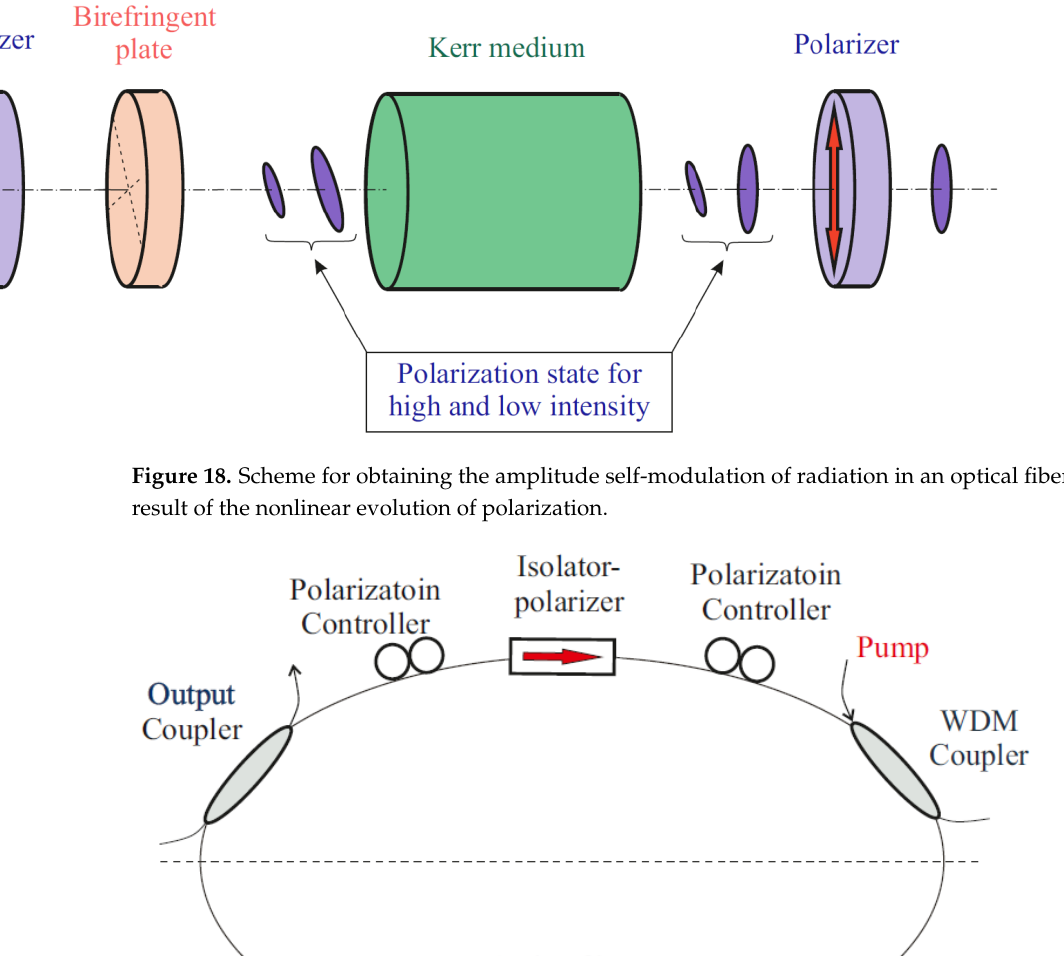
Figure 20. Nonlinear transmission function of an artificial glorifying absorber based on NEP. The phenomenon of rotation of the polarization ellipse concerning intensity was dis- covered in materials with Kerr nonlinearity in 1965 [178]. The first laser with mode-lock- ing based on this mechanism was implemented in 1972 [179]. The first passively mode-